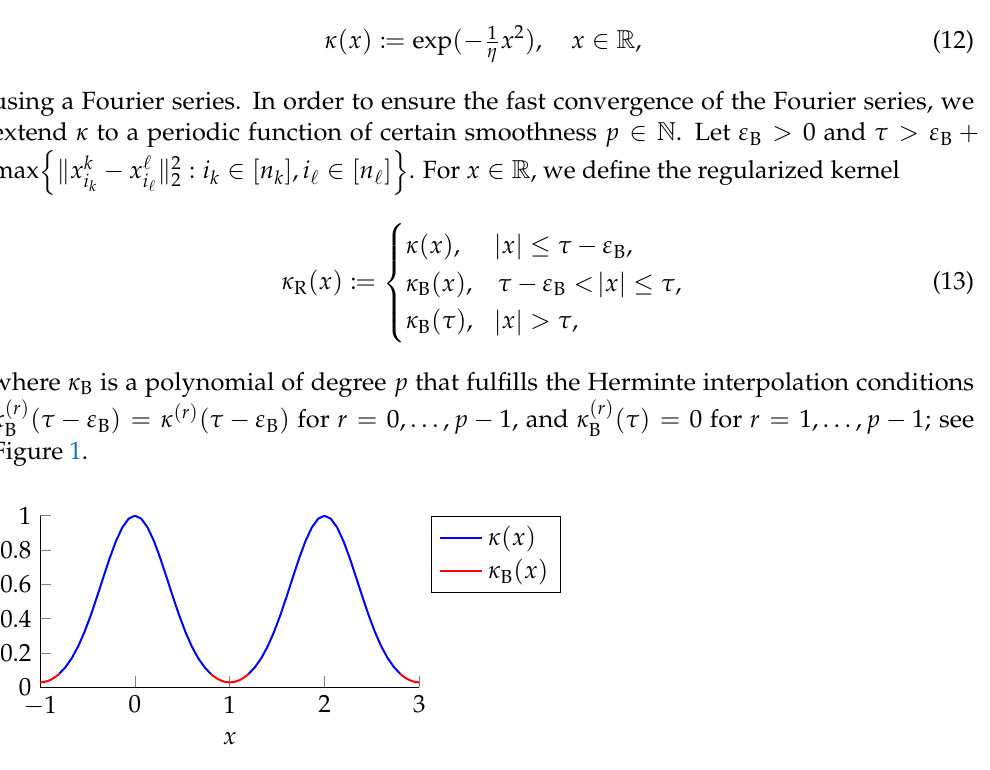
Figure 1. Regularized kernel κ R for η = 1/4, periodicity length τ = 1, boundary interval ε B = 0.2, and smoothness p =